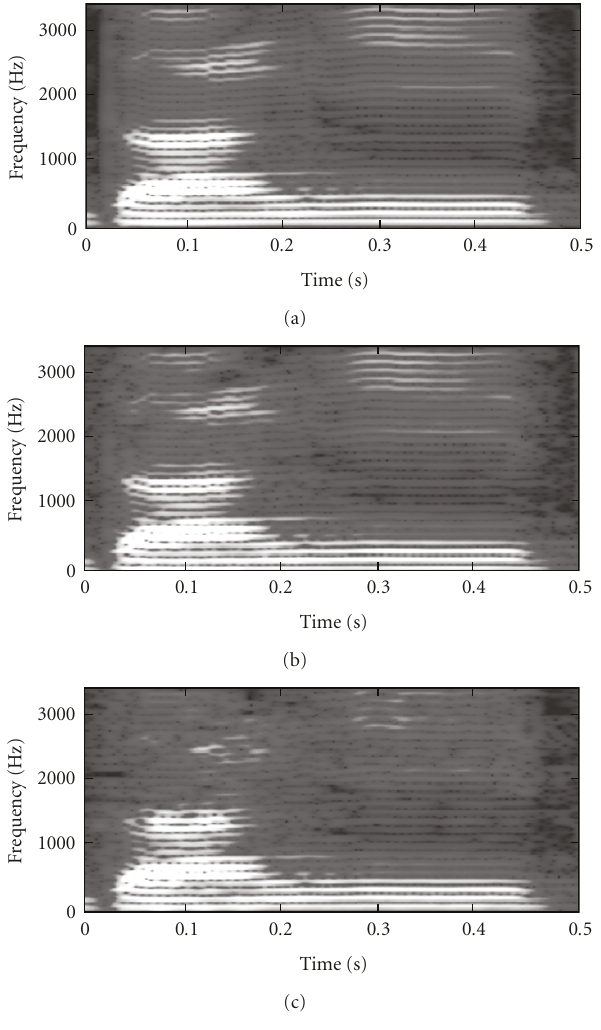
Figure 9: An example of speech spectrogram: (a) original signal, (b) synthesized signal using proposed algorithm, and (c) synthesized signal using EAAC without long-term prediction.